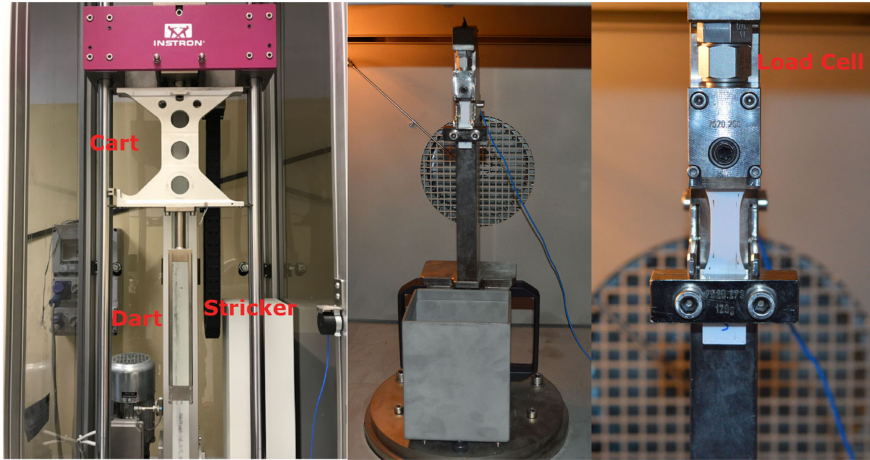
Figure 2. Striker bar system and an example of specimen mounted in the grips in the temperature-controlled